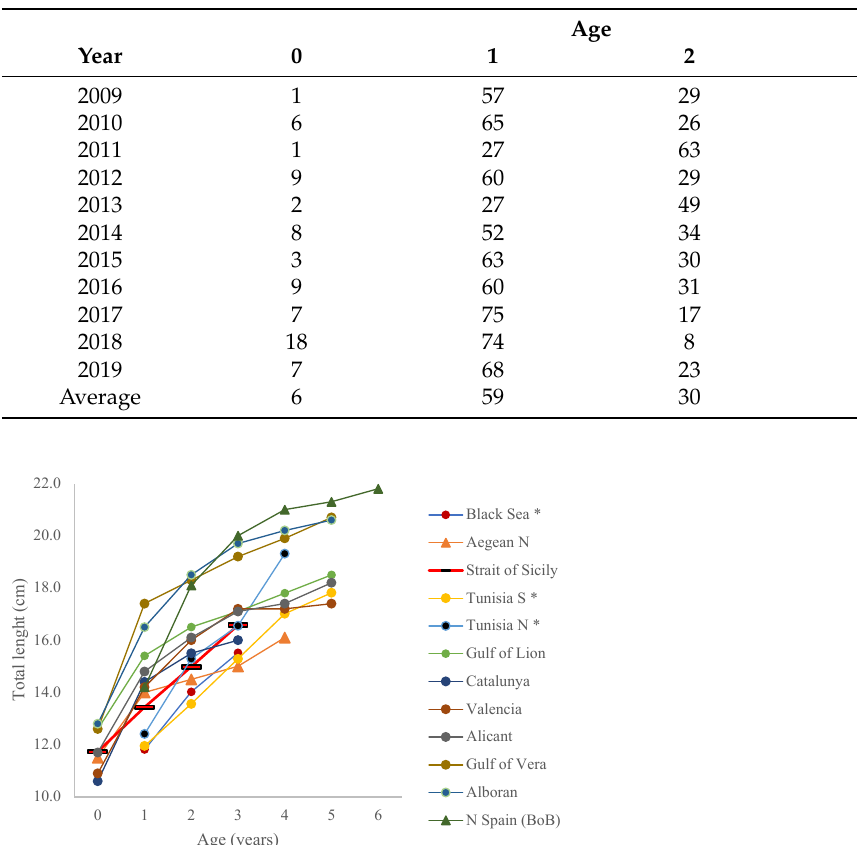
Figure 5. The age-length key (ALK) for sardine estimated during the study period (11 years: 2009– 2019). Total length (TL) is in cm. The ALKs obtained by year displayed ages from 0 to 3 years old with a higher proportion of individuals of Age 1 and Age 2 (respectively, 59% and 30%), while Age 0 and Age 3 were poorly represented in the landed catches with 6% and 5%, respectively (Table 4). However, the low proportion of Age 0 in the ALKs must be interpreted in the light of the minimum landing length, which is set to 11 cm for this species in the study areas, as also shown by landing length range in Figure 2. Table 4. Proportions (%) of individuals by age per sampling year (2009–2019) and average over the whole study period.